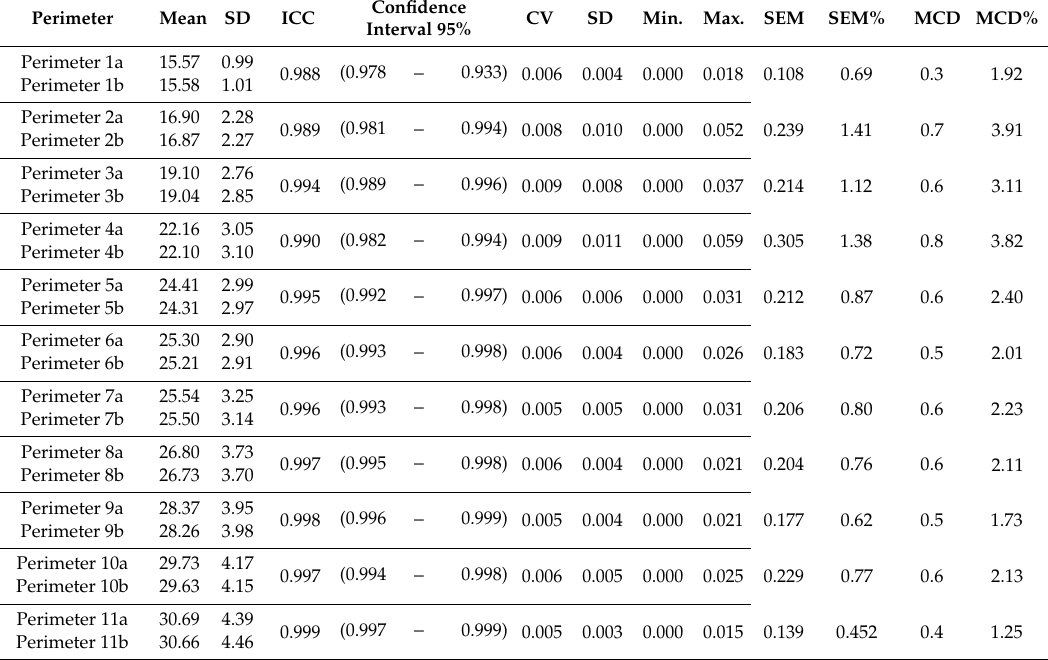
Table 2. Values and reliability of the perimeter measurements of the upper